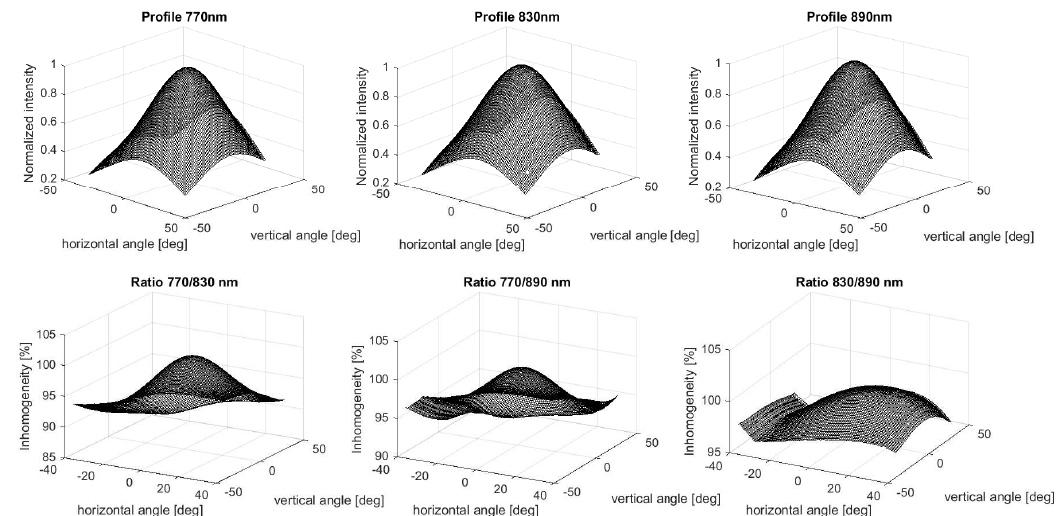
Figure 2. Color homogeneity measurements of the multi-wavelength narrow-band LED light source of Figure 1c (with diffuser). The measurements were done in a dedicated light box with an optical power